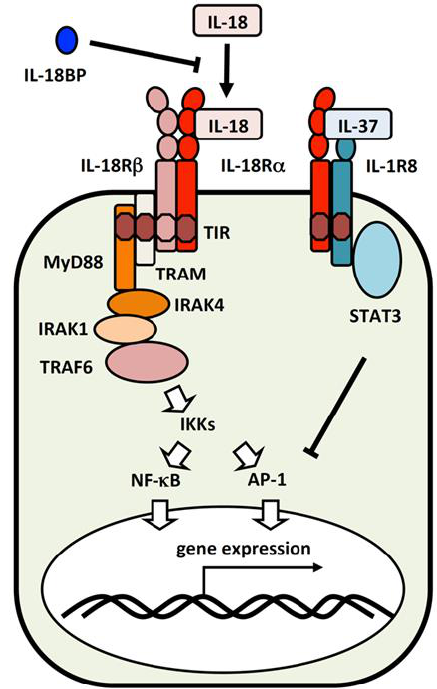
Figure 3. IL-18 signal transduction. When IL-18 binds to IL-18R α (black arrow), IL-18R β binds to the complex. IL-18 signaling activates the transcription factors NF- κ B and AP-1 via signal transduction molecules including MyD88, IRAKs, and TRAF6 (white arrows). IL-18BP competes IL-18 binding to IL-18R α . When IL-18R α binds to IL-37 it prevents binding to IL-18R β , which binds to IL-1R8 to send an inhibitory signal via STAT3.